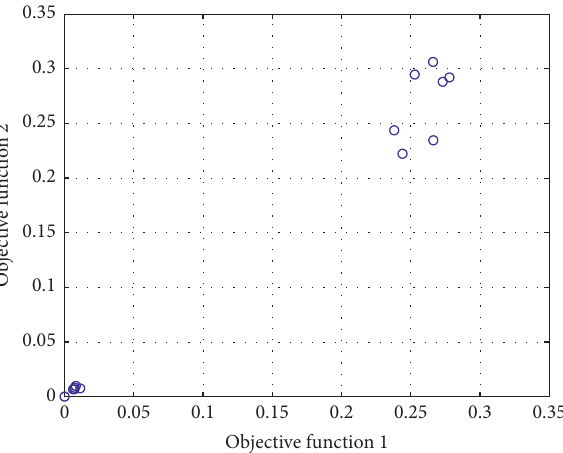
Figure 5: The Pareto set is based on two objective functions. Table 4: Results of solution by the NSGA-II algorithm.